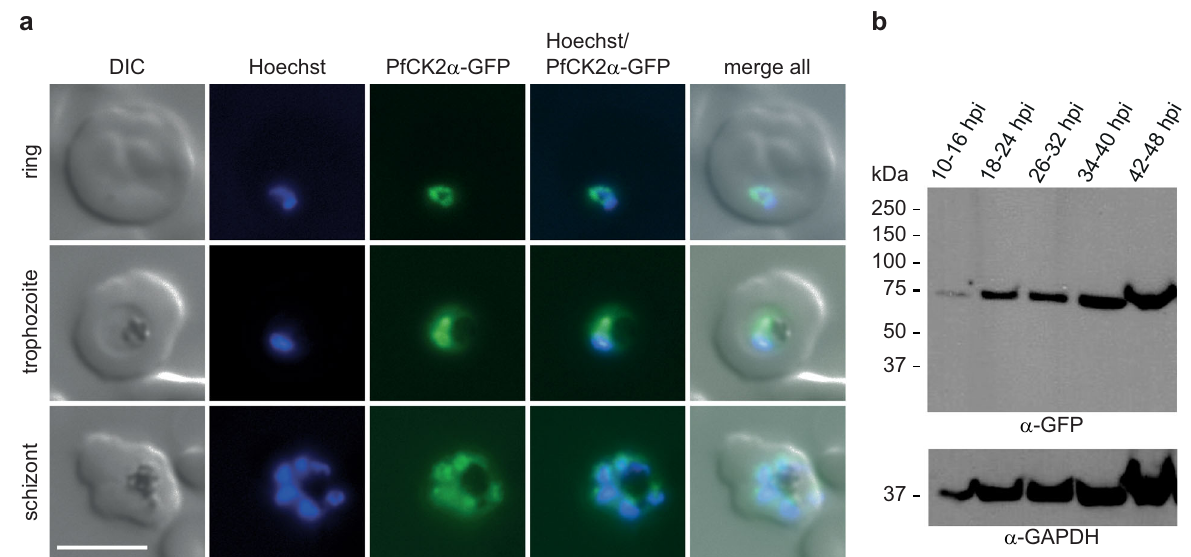
Fig. 1 Expression and localisation of PfCK2 α in NF54/AP2-G-mScarlet/CK2 α -GFP parasites. a Expression and localisation of PfCK2 α -GFP in ring, trophozoite and schizont stage parasites by live cell fl uorescence imaging. Representative images are shown. Nuclei were stained with Hoechst. DIC, differential interference contrast. Scale bar = 5 µ m. b Western blot analysis showing expression of PfCK2 α -GFP at several time points during the IDC. Protein lysates derived from an equal number of parasites were loaded per lane. MW PfCK2 α -GFP = 66.8 kDa, MW loading control PfGAPDH = 36.6